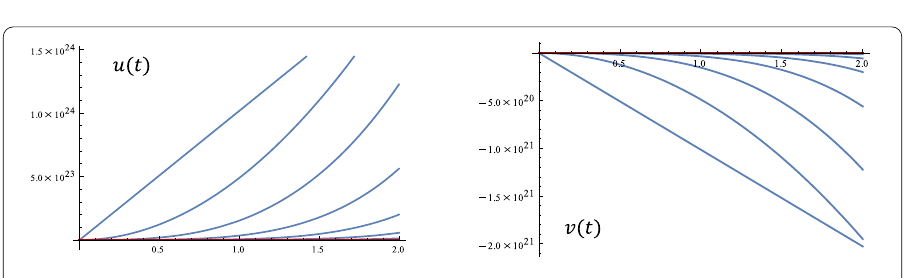
Figure 6 The solutions behavior of Example 4.2 for α i = 0.1 + 0.1 i , i = 0,1, ...